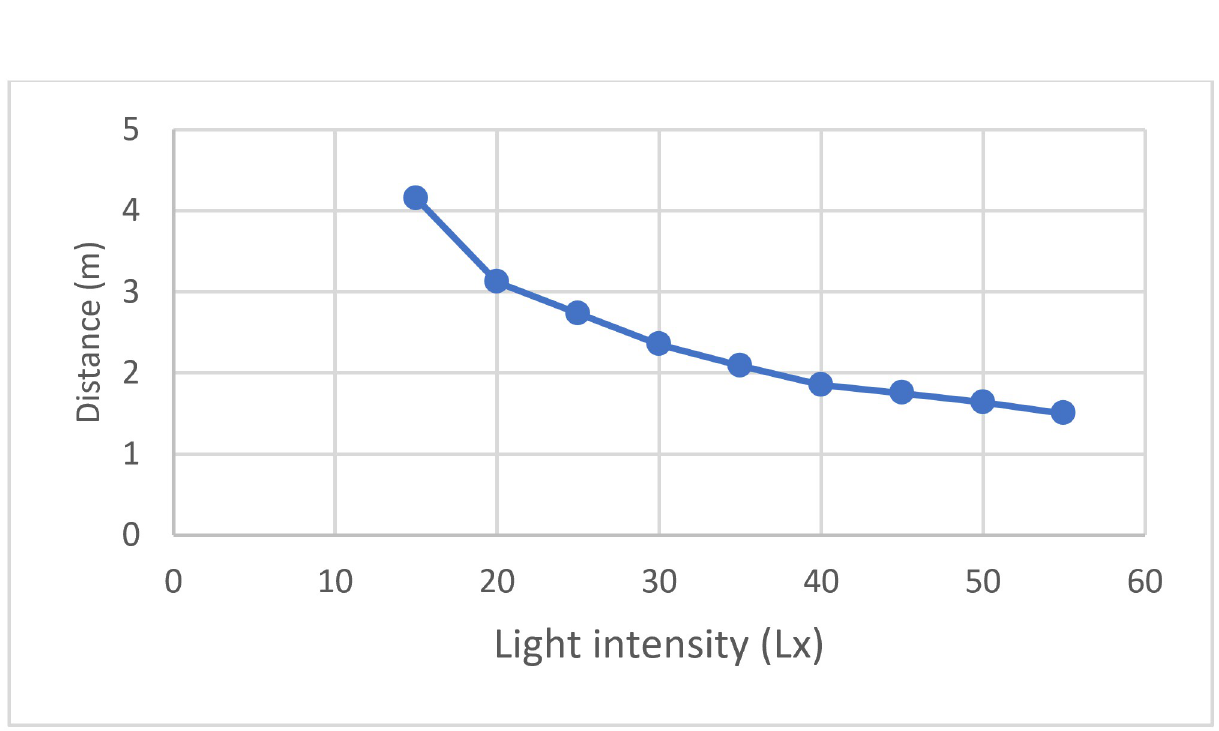
Fig 11. The light intensity (lx) and the distance between user and LED.